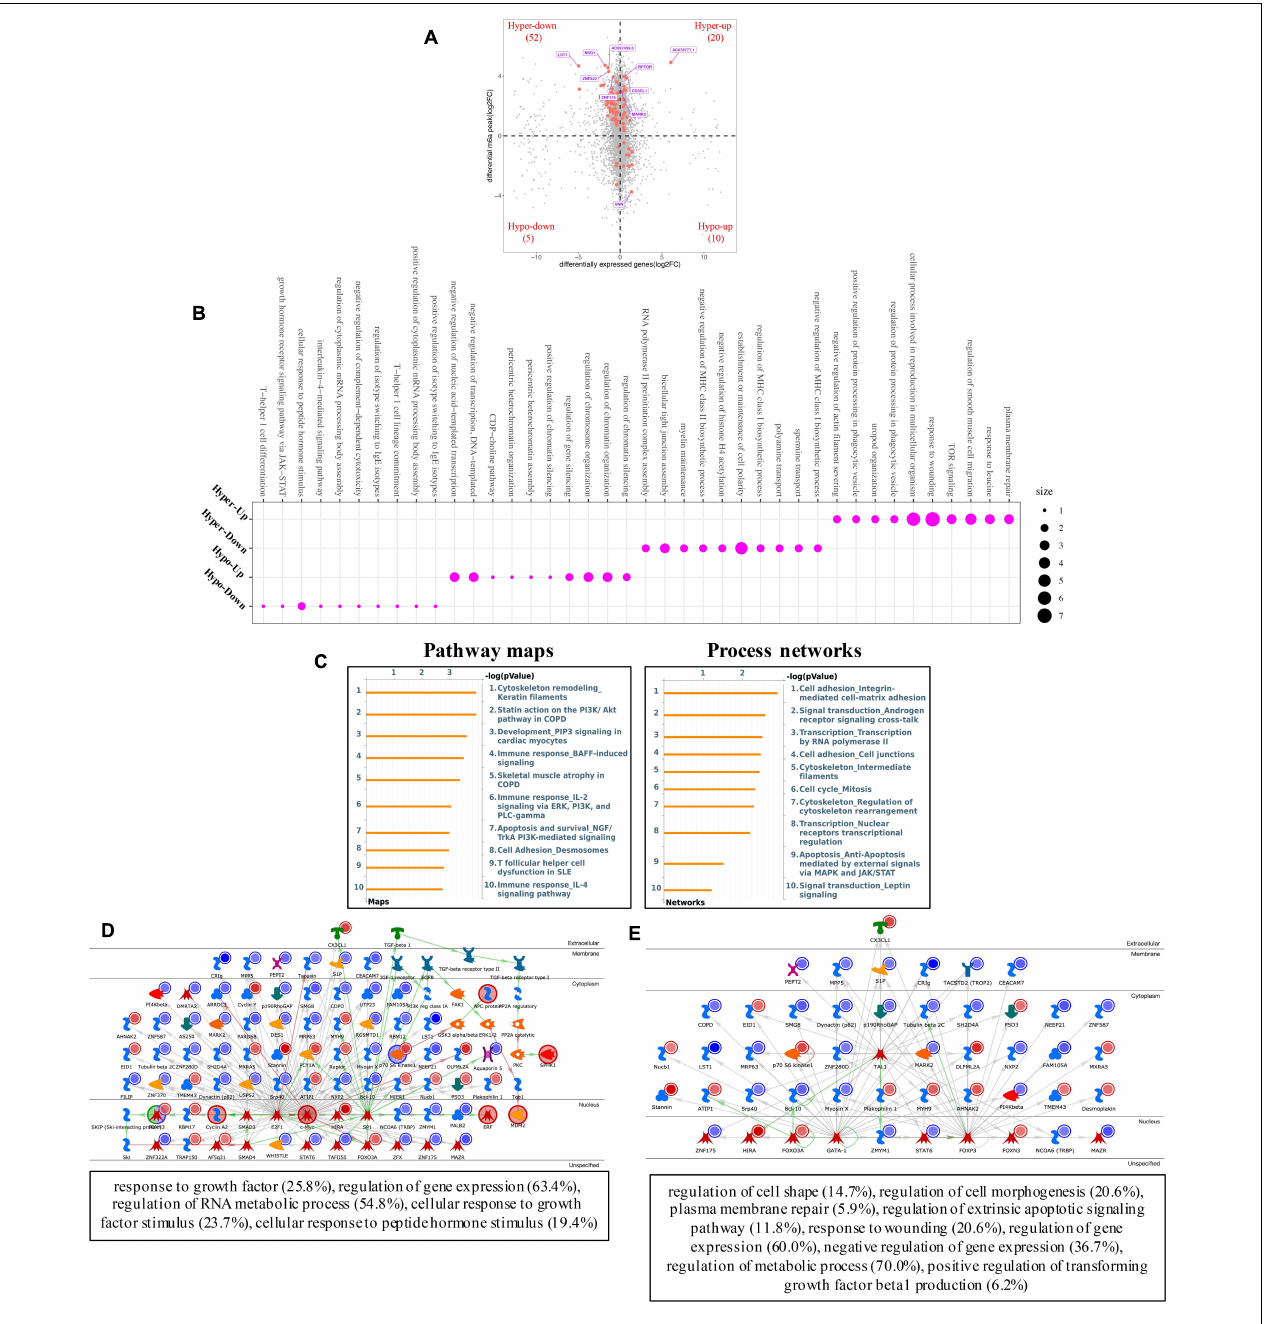
FIGURE 7 | Systematical analyses of MeRIP-seq and RNA-seq data in pterygium. (A) Significantly m6A-modified RNA identified after conjoint analyses of MeRIP-seq and RNA-seq data. (B) Bubble diagram of GO biological process categories enriched for DEGs with m6A hyper- or hypo-methylated. (C) Pathway maps analysis (left) and Process networks analysis (right) of differentially m6A-modifed genes. (D) Top three scored networks analysis of m6A-modified genes. (E) Key transcription factors and target genes network analysis of m6A-modifed genes. DEGs, differentially expressed